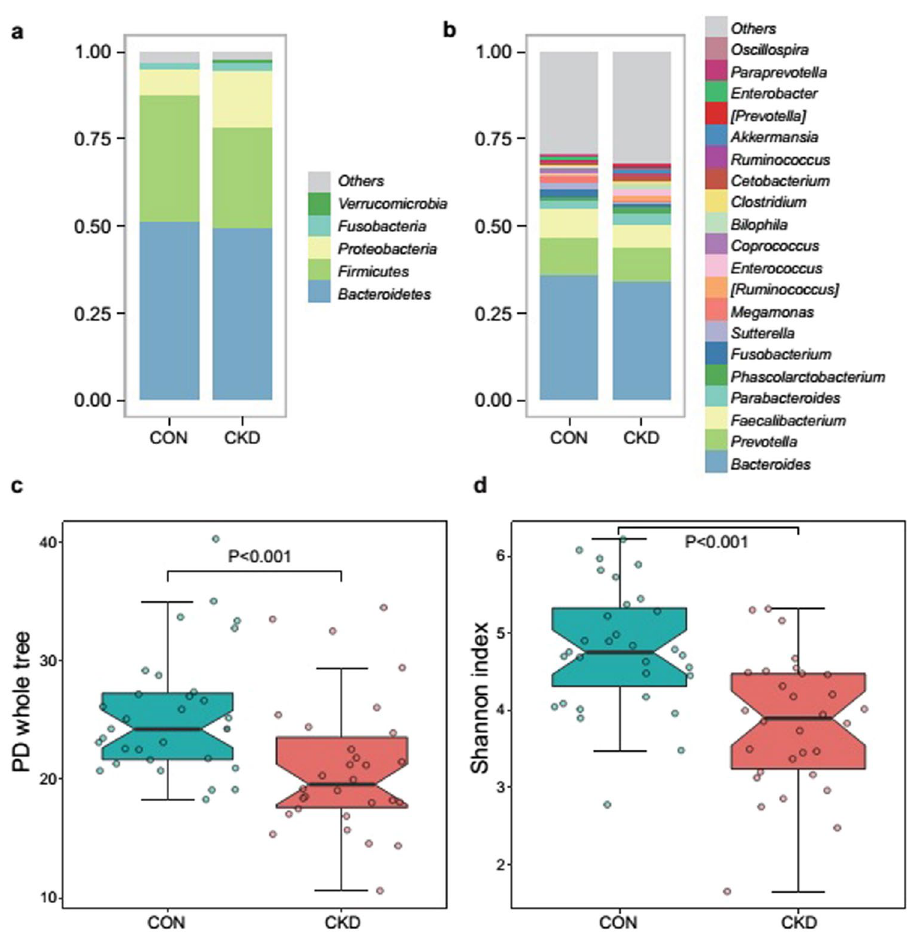
Figure 2. The healthy controls exhibited significantly greater bacterial diversity than the patients. The data represent the comparison of gut bacterial profiles between the healthy controls and CKD patients, including 31 healthy controls (blue) and 30 CKD patients (red). ( a,b ) Average relative abundances of the predominant bacterial taxa at the phylum level and the genus level in the CKD patient and control samples. ( c,d ) Comparison of α -diversity between the gut microbiota of the CKD patients and controls. We used two indices to represent the α -diversity (the Shannon index and the PD whole tree). PD indicates phylogenetic diversity. The Wilcoxon rank sum test was used to determine significance in α